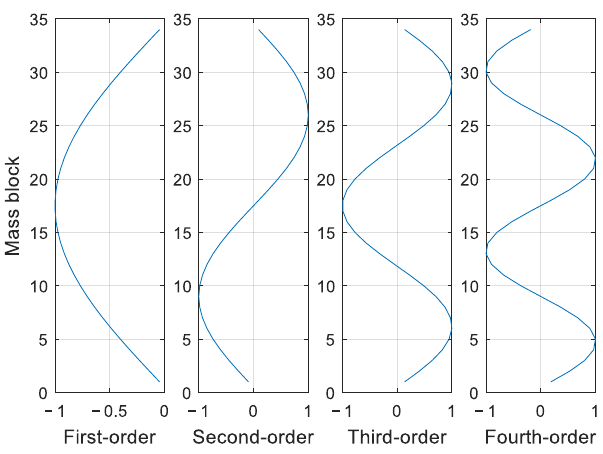
Figure 4. The first four modes.